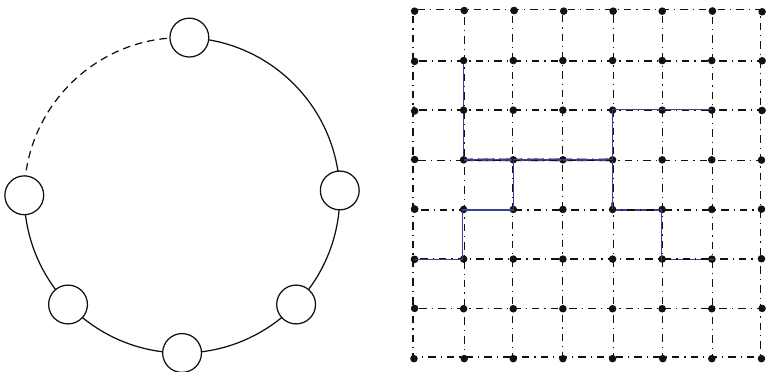
Figure 3: The ring and grid topologies used to evaluate the flow oriented graph coloring (FOGC) heuristic algorithm.